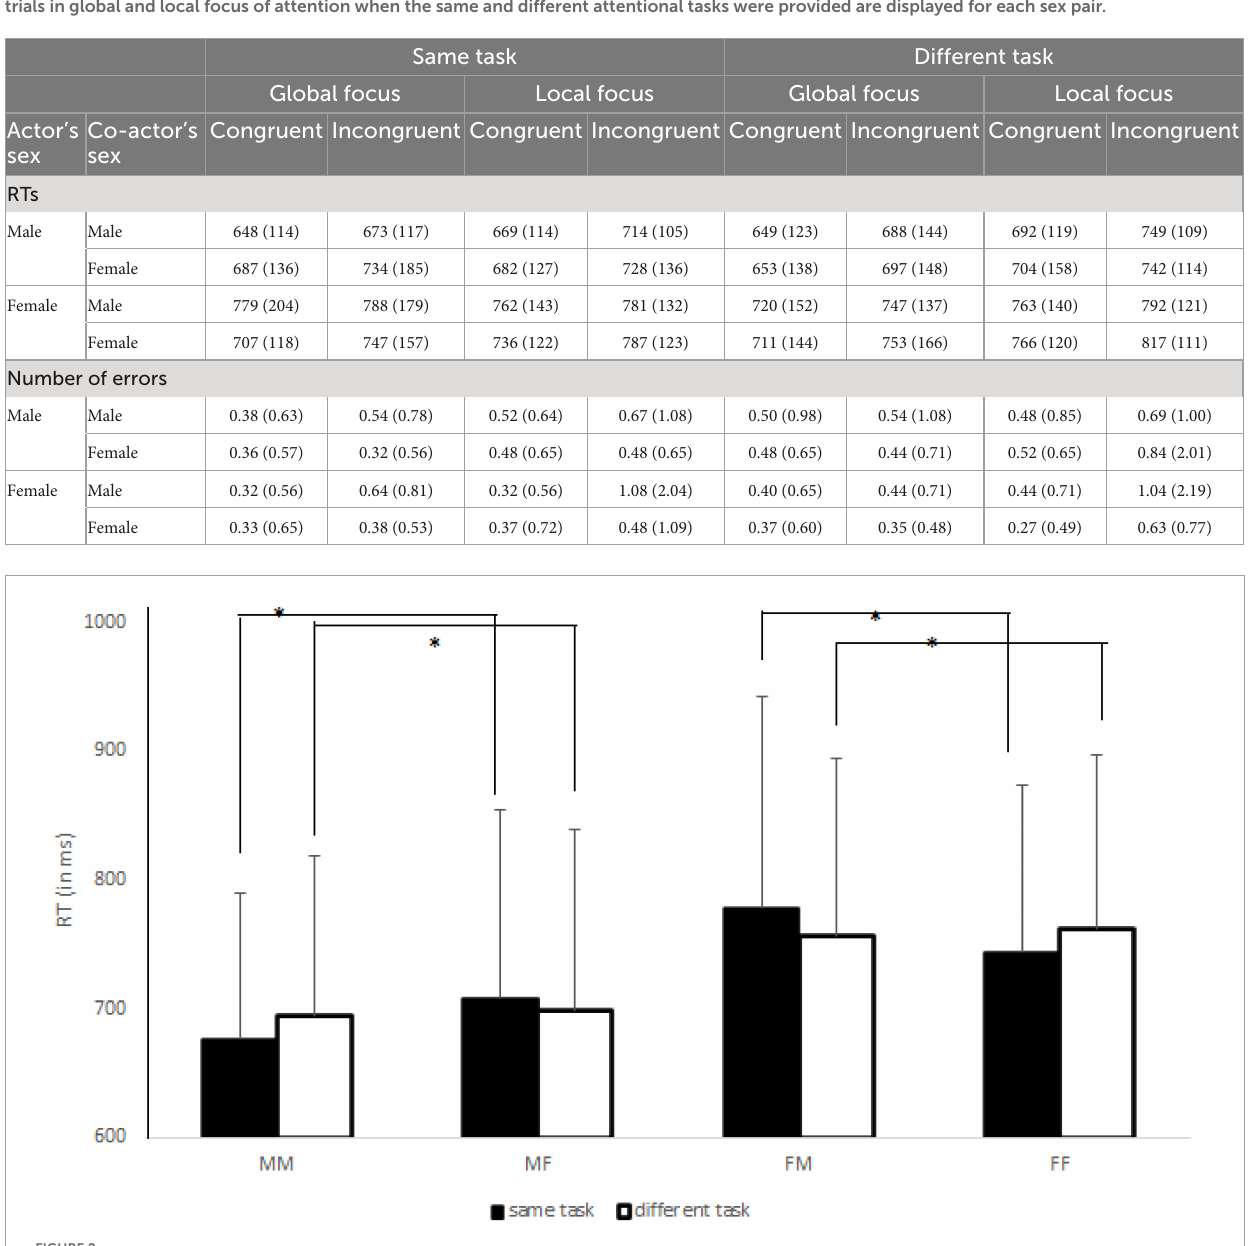
FIGURE2 The joint Navon effect (JNE) for each sex pair (MM, male-male; MF, male-female; FM, female-male; FF, female-female) in same (black histograms) and different (white histograms) task blocks. The asterisks indicate the significant comparisons. The bars represent the standard